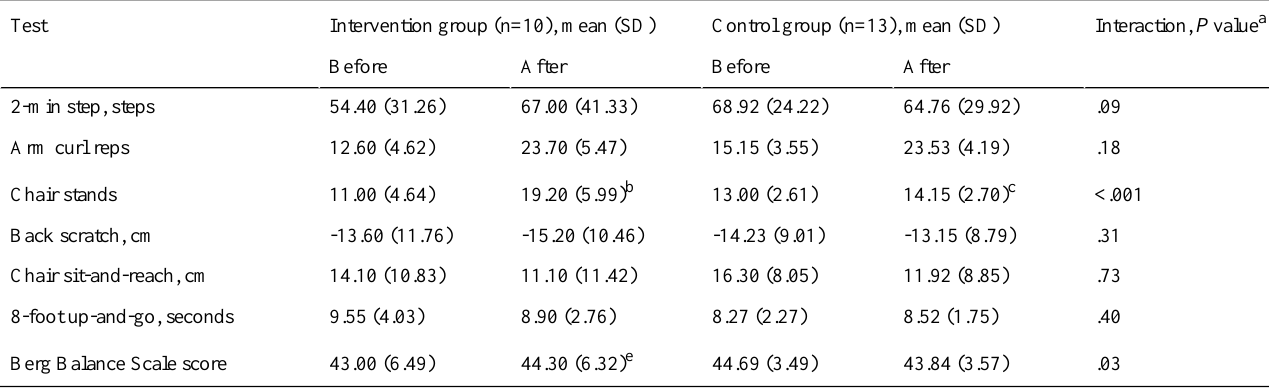
Table 3. Changes in physical function. Before and After refer to measurements taken before and after the 12-week intervention period, respectively.